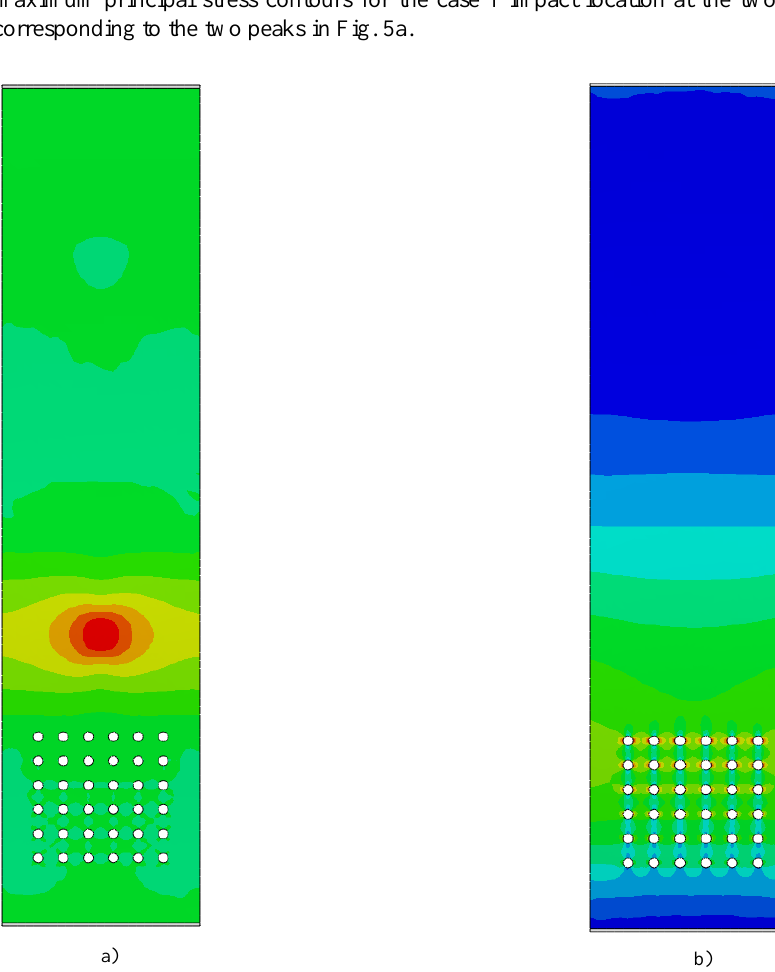
Fig. 8 Results of numerical simulations for case 1 impact location: a) Maximum in-plane principal stress contours at 16 ms and at b) 37